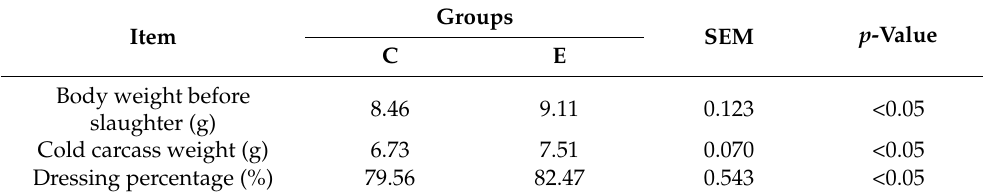
Table 3. Slaughter value of turkey